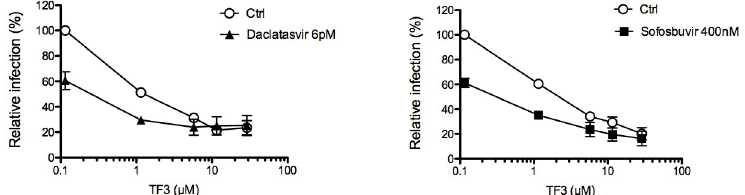
Fig 7. Theaflavins can be used in combination with DAA. Huh-7 cells were inoculated with HCV JFH-1 in the presence of TF3 at given concentrations. Inoculum was removed and replaced by medium containing or not either Daclatasvir at 6 pM or Sofosbuvir at 400 nM. Cells were fixed at 30 h post infection and subjected to immunofluorescent detection of E1 envelope protein. Results are expressed as mean +/- SEM (error bars) of 3 independent experiments performed in triplicate. Data are normalized to DMSO, which is expressed as 100% infection.